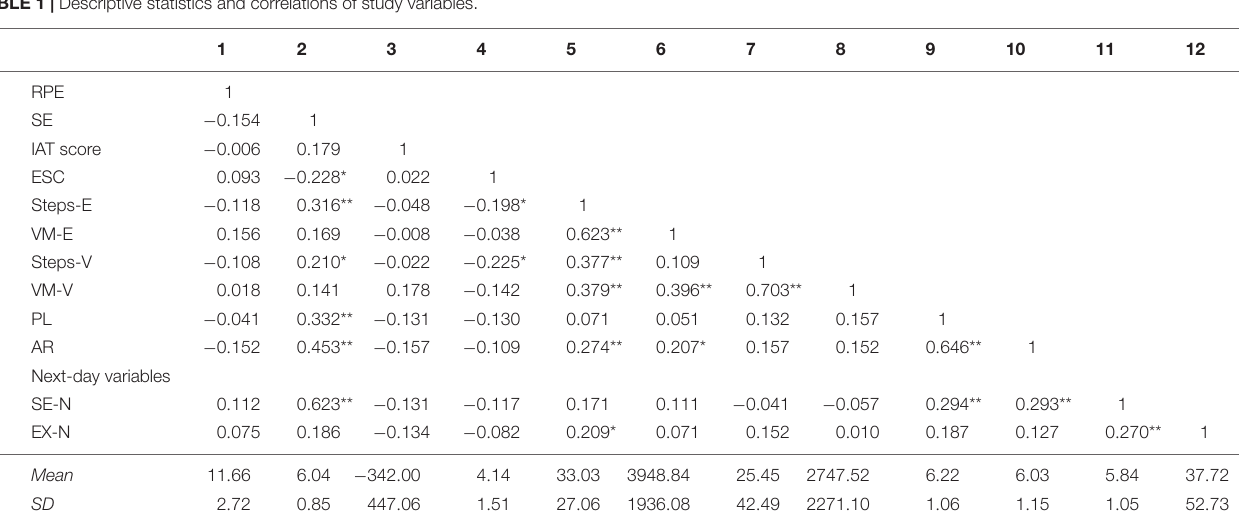
TABLE 1 | Descriptive statistics and correlations of study variables.